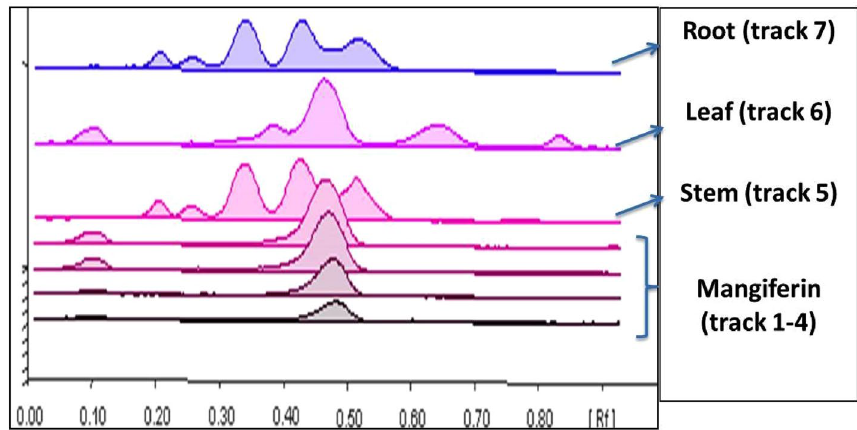
Figure 1. HPTLC profiles (overlay) of different plant parts of Swertia chirata (mobile phase: ethyl acetate- formic acid-glacial acetic acid–water: 100-11-11-26), Track 1–4 (standard mangiferin: 200 ng, 400 ng, 600 ng and 800 ng respectively, Rf-0.47), Track 5, 6 and 7 are stem, leaf and root,